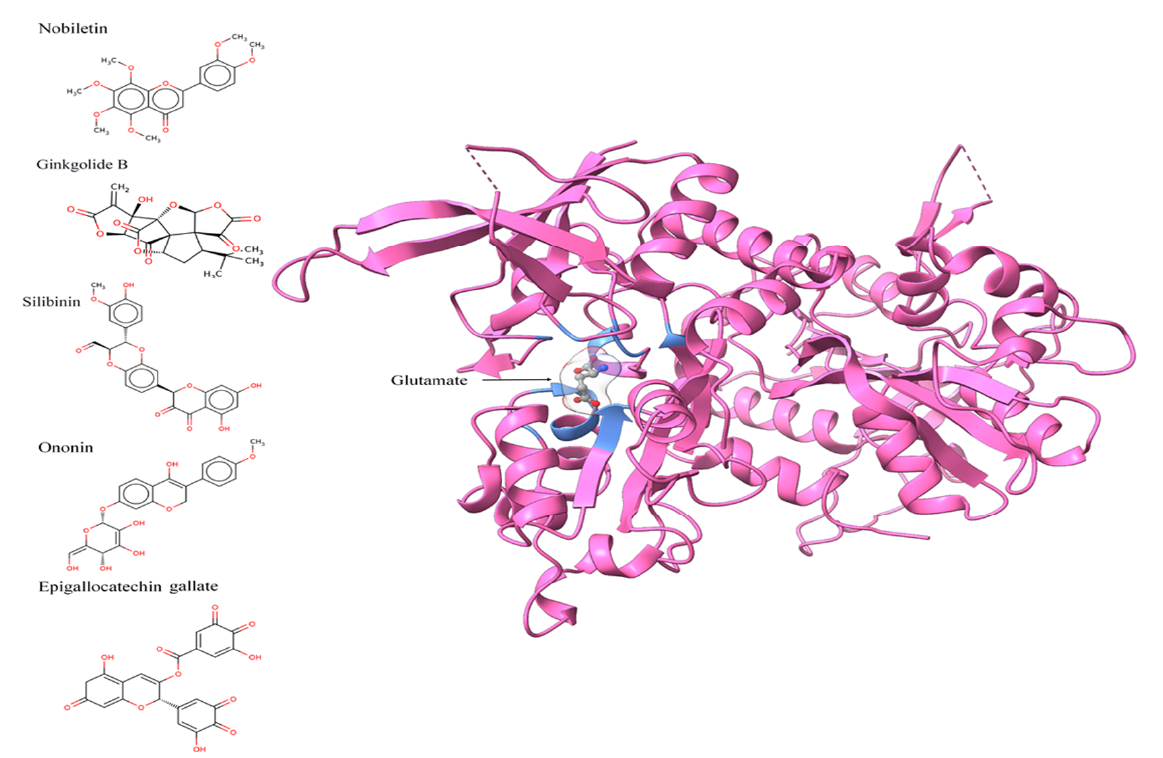
Figure 1. Two-dimensional images of nobiletin, ginkgolide B, silibinin, ononin, and epigallocatechin gallate, and three-dimensional pose of NMDA receptor displaying the glutamate binding and amino acids within <5 angstrom distance, in blue color.